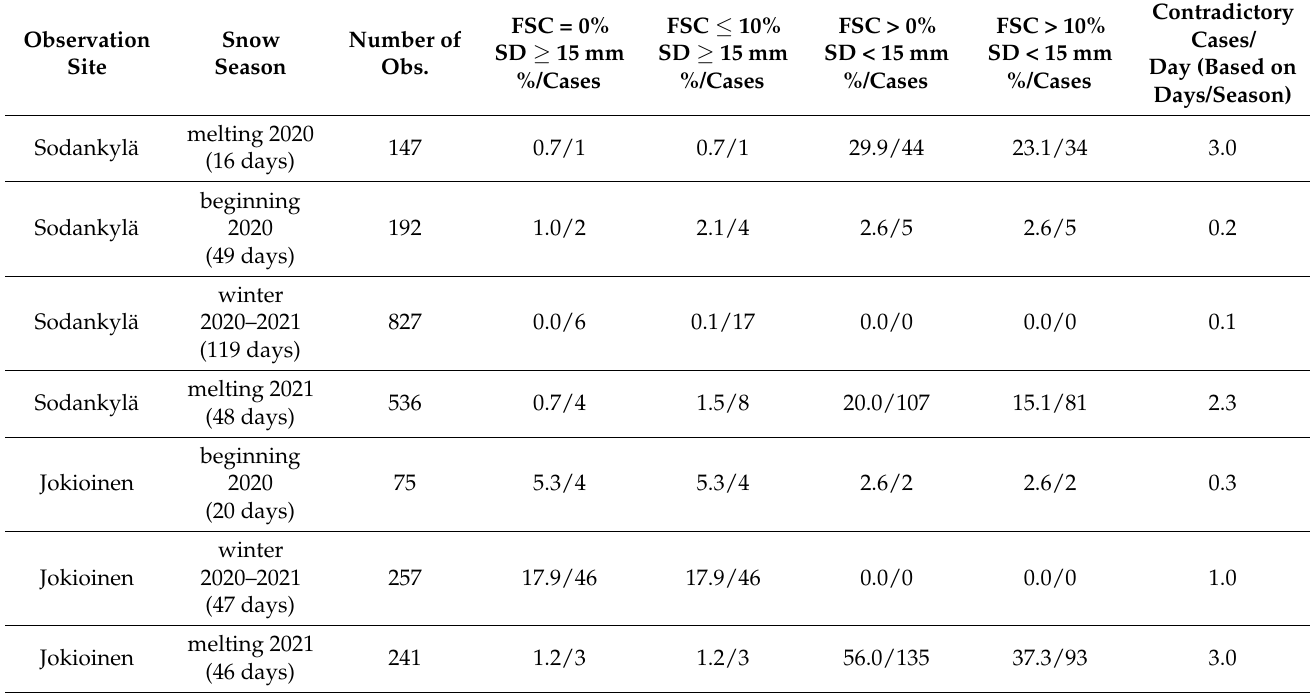
Table 4. Comparison between FSC and SD data observed in Sodankylä and